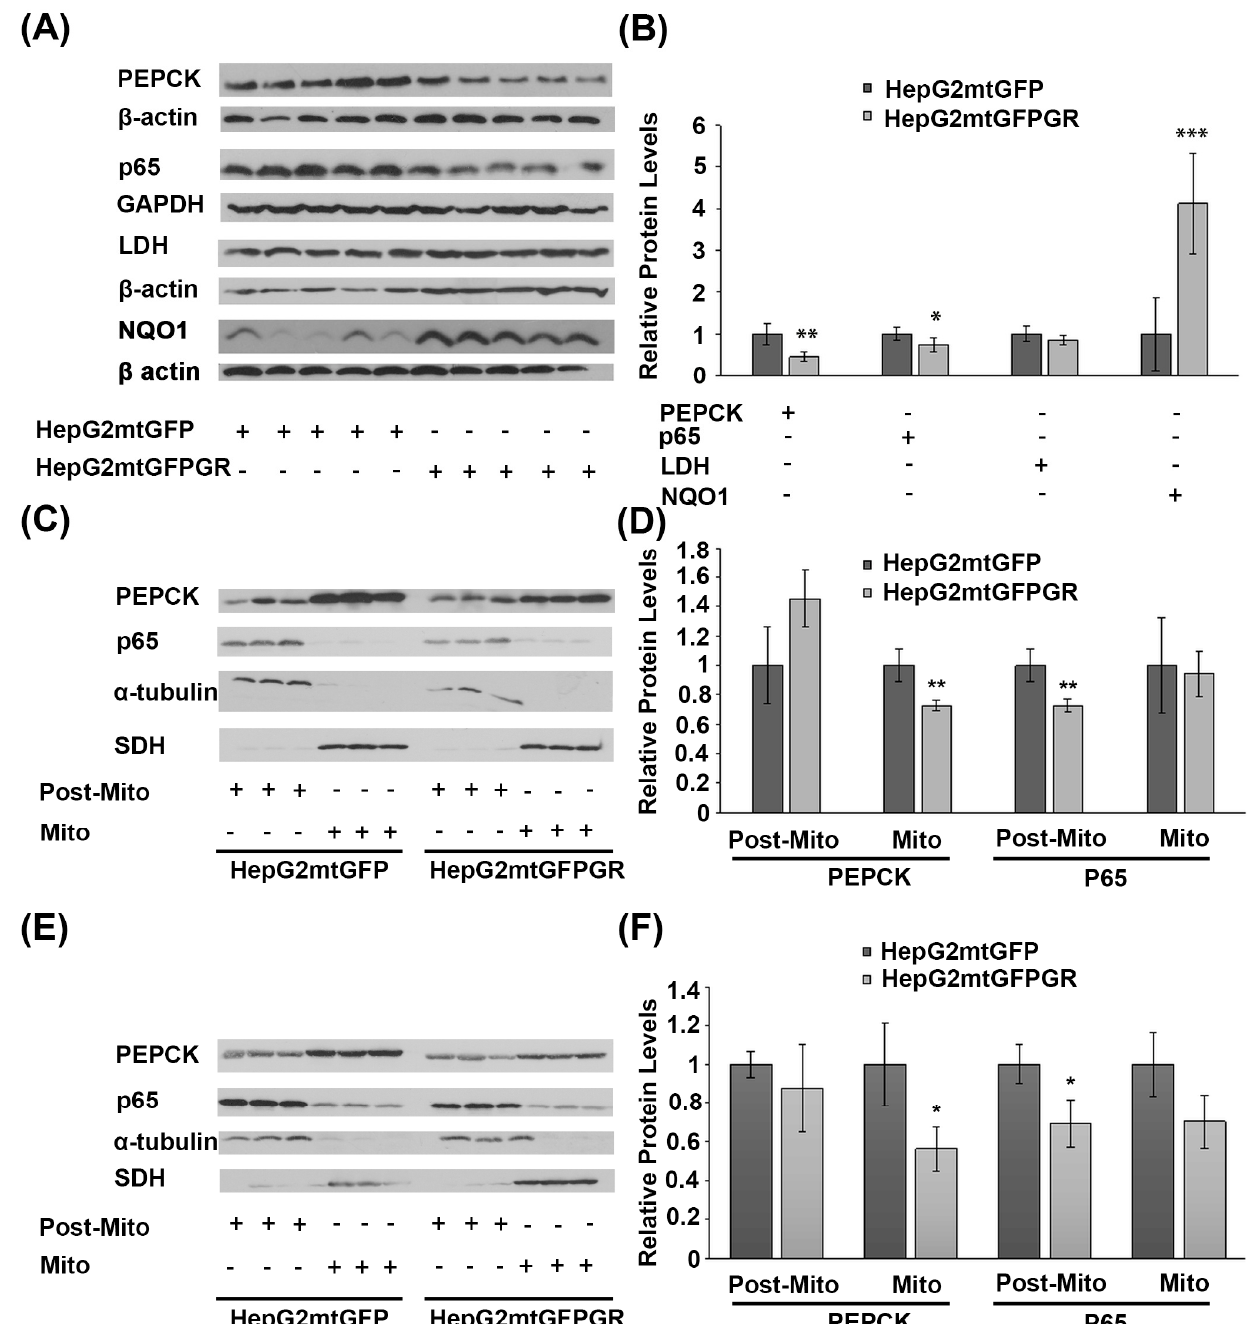
Figure 9. Increased mitochondrial localization of GR affects protein levels of glucose metabolism enzymes and inflammatory factors in cancer cells derived from xenografted tumors. ( A ) Western blot analysis of PEPCK, p65, LDH, and NQO1 in total extracts from tumors produced in NOD-SCID mice, inoculated with HepG2mtGFPGR or HepG2mtGFP (control) cells. ( B ) Quantification of the results. Protein levels of β -actin or GAPDH protein levels were used for the normalization of the results. Data are expressed as mean ± S.D ( n = 5), * p < 0.05, ** p < 0.01, *** p < 0.001, compared to controls. ( C , F ) Western blot analysis of PEPCK and p65 in the post-mitochondrial (Post-Mito) and mitochondrial (Mito) extracts from tumors produced in NSG mice, inoculated with 1 × 10 4 ( C , D ) or 1 × 10 5 ( E , F ) HepG2mtGFP or HepG2mtGFPGR cells. SDH and α -tubulin were used for the normalization of protein levels in mitochondrial and post-mitochondrial extracts. Relative protein levels were expressed as mean ± S.D ( n = 3), * p < 0.05, ** p < 0.01, compared to